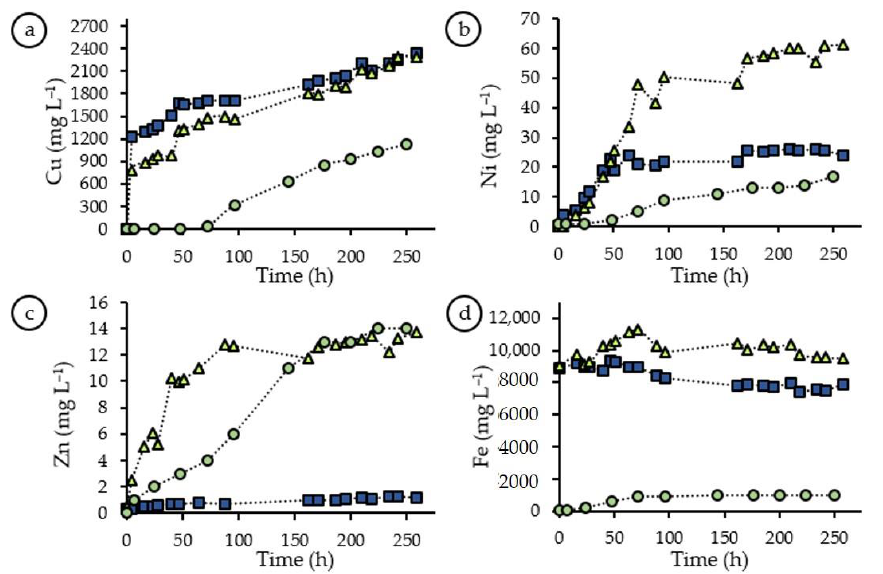
Figure 5. Extracted amount of ( a ) copper, ( b ) nickel and ( c ) zinc, and ( d ) total iron concentration during the two-step bioleaching experiment (blue square) and leaching experiments in abiotic medium employing biogenic Fe 3+ (yellow triangle) or H 2 SO 4 (green circle) as leaching agents. In the case of copper dissolution in the presence of bacteria, the metal removal rate peaked during the first 4 h (309 mg Cu L −1 h −1 ) and decreased significantly (<6 mg Cu L −1 h −1 ) in the following 12 h (Figure 5a). After 218 h, the extracted amount of copper differed by less than 2% in Fe 3+ biotic and abiotic medium, revealing the poor contribution of the suspended biomass to the copper solubilization rate [43].